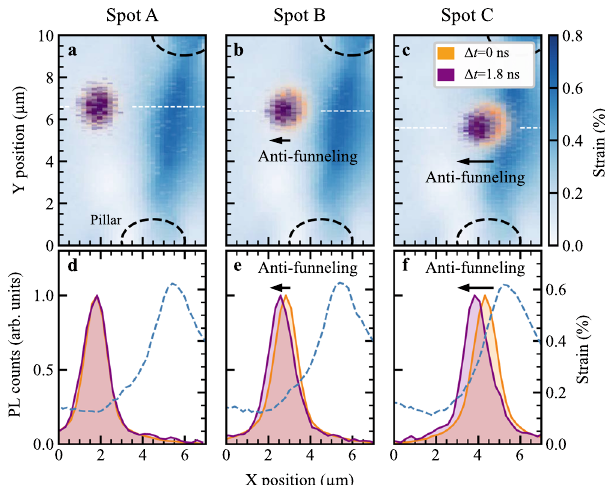
Fig. 2 Exciton anti-funneling. a – c Spatially resolved photoluminescence from an inhomogeneously strained WS 2 monolayer upon pulsed excitation at a delay time 0 ns (orange) and after 1.8 ns (purple). The blue colormap depicts the measured strain gradient induced by the micropillars. d – f Cuts along the x direction (horizontal white dashed line) in fi gures a – c . The dashed blue line shows the strain distribution along the x direction. We fi nd that excitons do not propagate in absence of a strain gradient (spot A). Surprisingly, they funnel towards lower-strain regions (opposite to conventional funneling), when the excitation spot is subject to a considerably large strain gradient (spot B and C). The supplementary material includes PL movies further illustrating this surprising anti-funneling